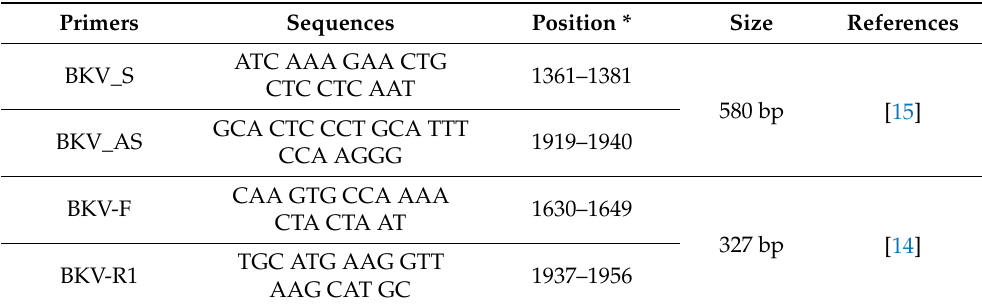
Table 1. Primer sequences used in this